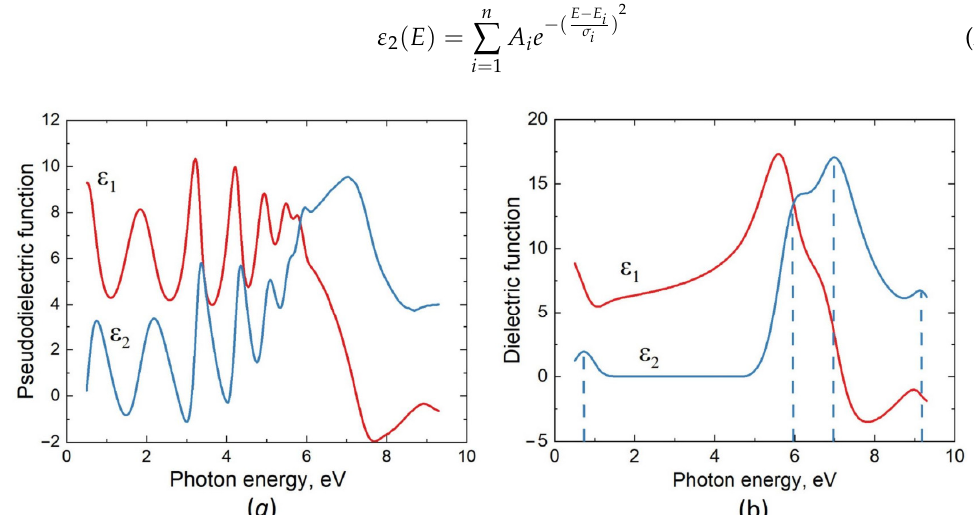
Figure 1. Pseudodielectric function of a 3C–SiC sample grown by MCSA on the n-type Si(111), as measured with the VUV-VASE ellipsometer ( a ), and dielectric function of the sample, as extracted from the measured data ( b ). ε 1 is the real part and ε 2 is the imaginary part; the dashed lines show the positions of the peaks of the ε 2